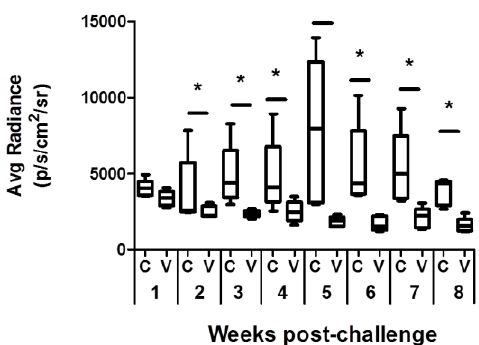
Figure 1. Evaluation of the L. infantum infection by in vivo bioluminescent imaging (BLI). BALB/c mice ( n = 5 per group) were inoculated s.c. (left footpad) with PBS (control group) or vaccinated with 10 7 Li ∆ HSP70-II attenuated parasites prepared in PBS. Twelve weeks after inoculation, animals were challenged i.v. with 10 8 PpyRE9h + L. infantum infective promastigotes. Radiance data are represented as box and whisker (min to max) plots. Statistics were obtained using a Mann–Whitney test. * shows the statistical differences between control and vaccinated mice ( p < 0.05). Results are representative of two independent experiments.